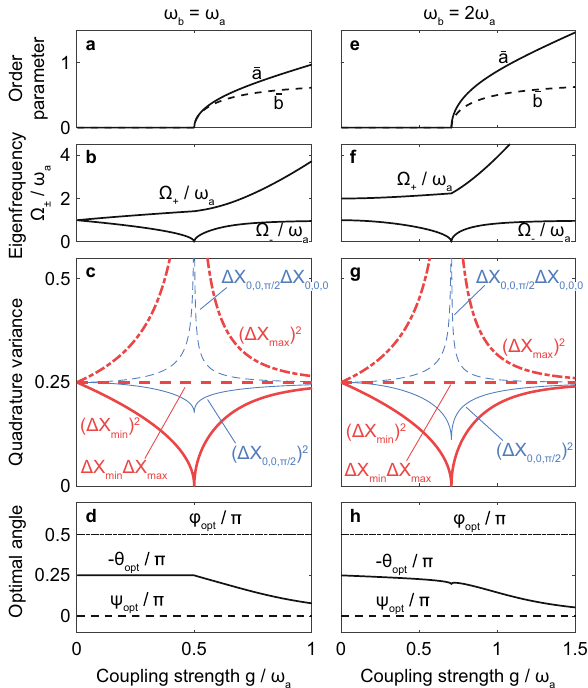
ω a and ( e–h ) ω b 2 ω a . = = ; ( c, g ) quadrature ± 1 / 4 =